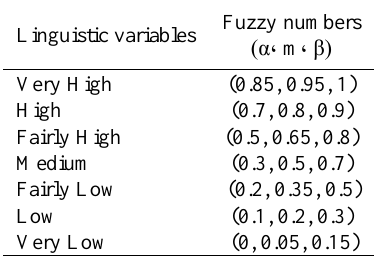
Table 1. Linguistic variables and fuzzy numbers for the importance weight (Lin et al., 2006)